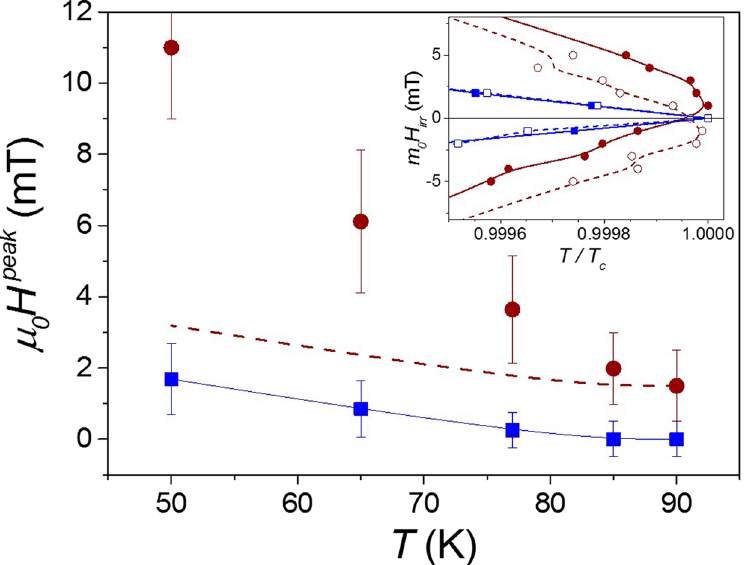
Figure 4. Temperature dependence of μ 0 H peak . Magnetic field position of the peak in the critical current density and critical temperature at different temperatures for a bridge with antidots (squares) and antidots filled with nano-rods (circles). Dashed line shows the temperature dependence obtained by sum of squared points and the contribution of nano-rods at high temperature. Inset shows the irreversibility line measured decreasing field (closed symbols) and increasing field (open symbols), for the bridge with antidots (squares) and antidots filled with nano-rods